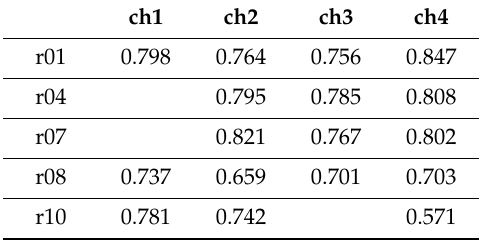
Table 2. Correlation coe ffi cients between the extracted FECGs and the clean scalp FECGs.